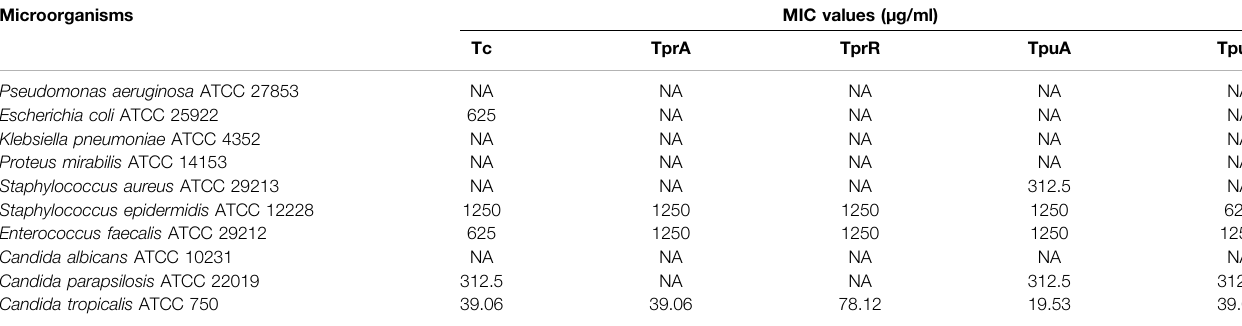
TABLE 5 | Antimicrobial activity results of the studied Thymus extracts. Microorganisms